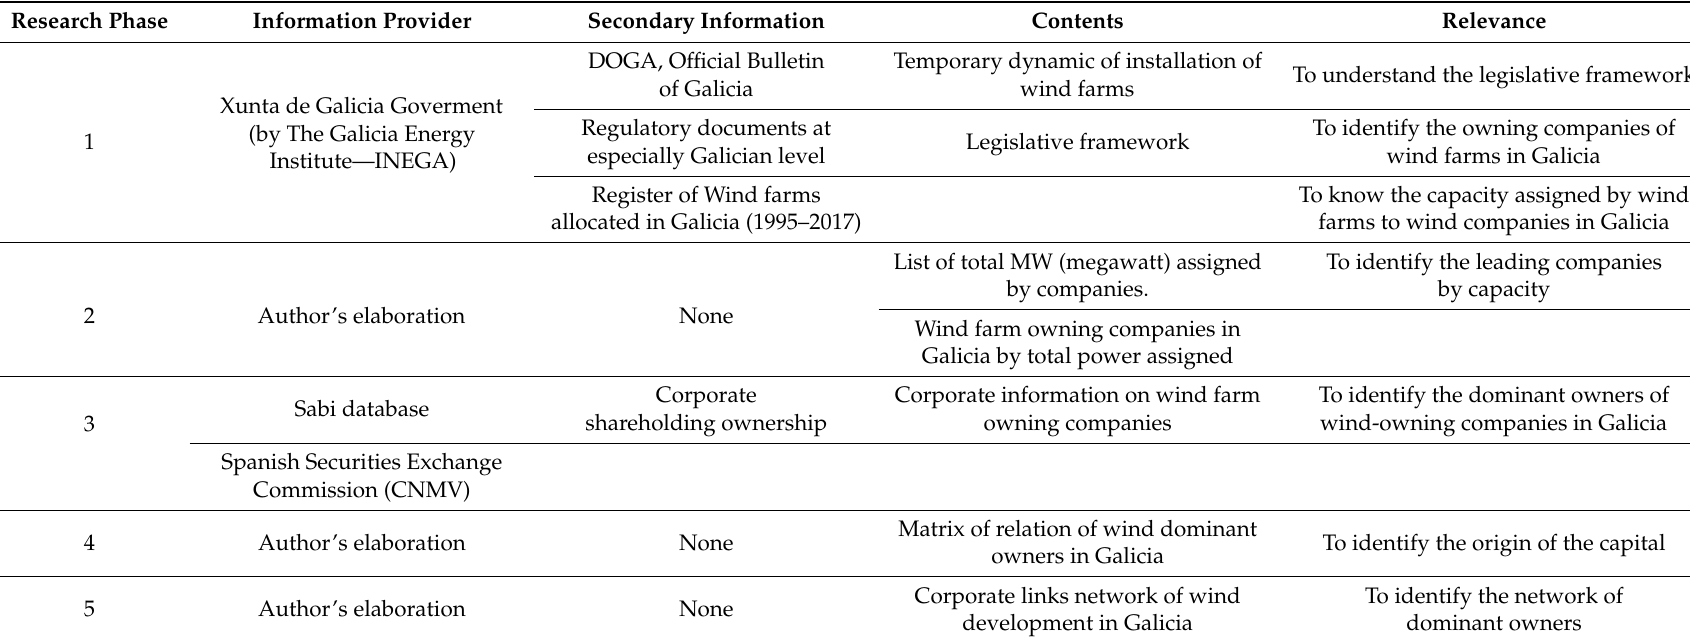
Table 1. Research